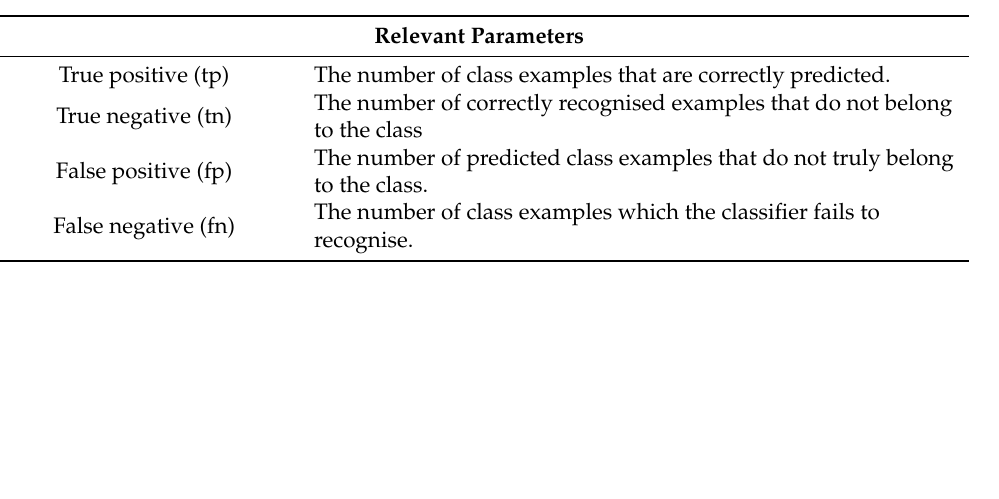
Table 5. Performance metrics used for analysing the performance of the classifiers.